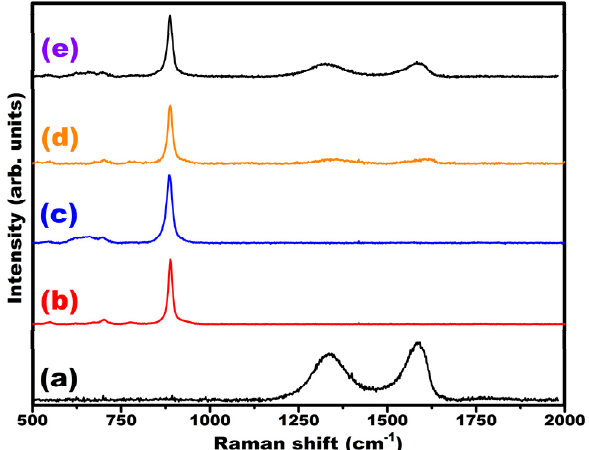
Figure 2. Raman analysis of the electrocatalysts, GO ( a ), MW-7 ( b ), MW-12 ( c ), MW@GO-7 ( d ), and MW@GO-12 ( e ).